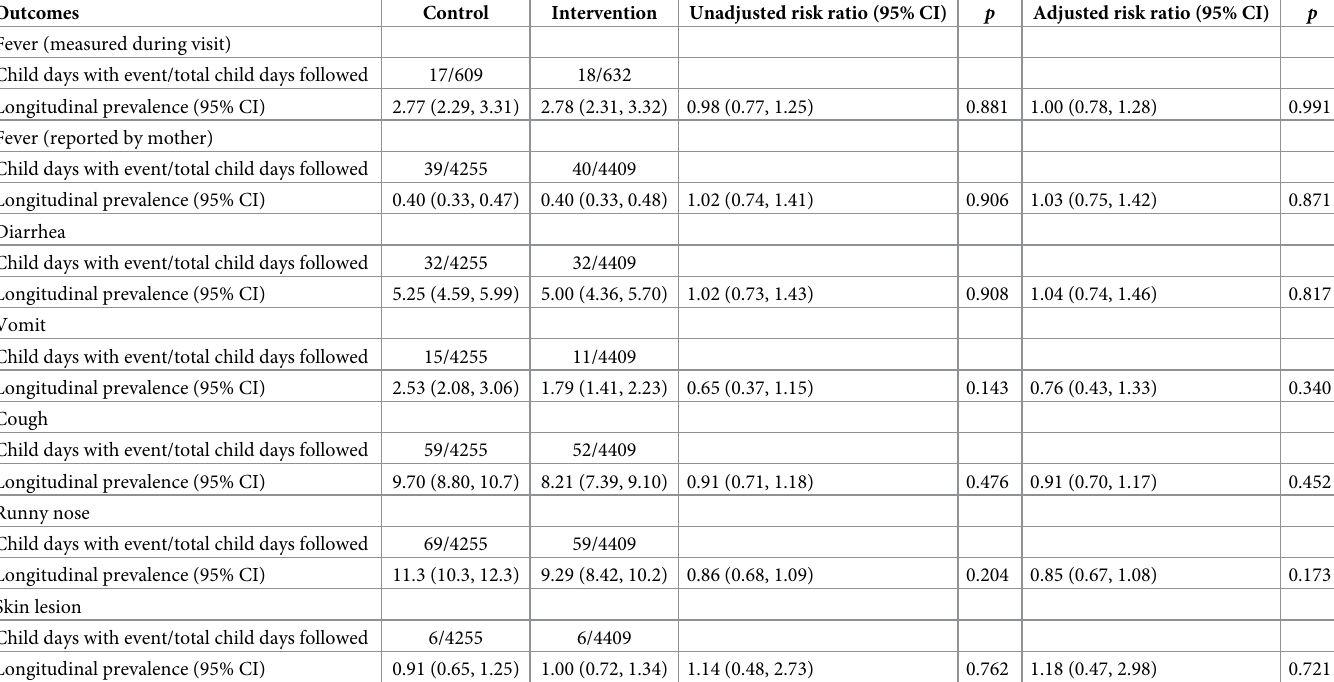
Table 5. Effect of maternal postnatal BEP supplementation on infant morbidity during the 6 months postpartum follow-up 1 .